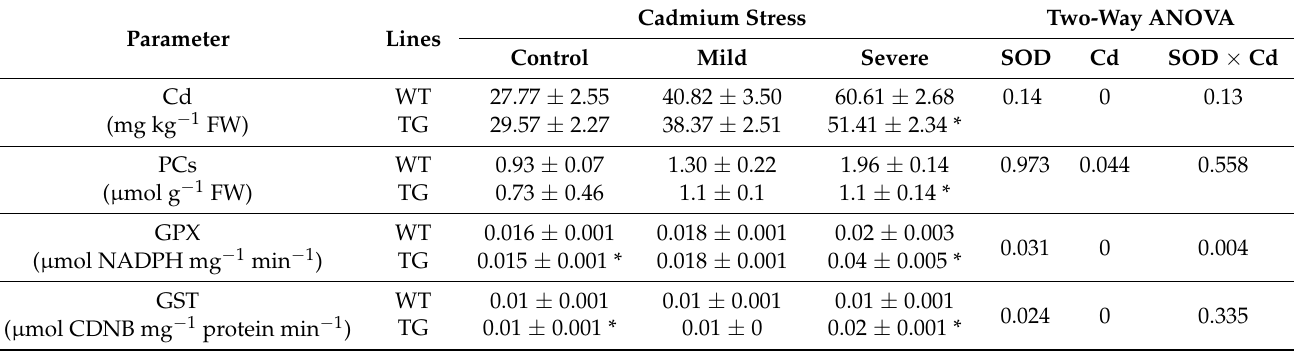
Table 3. Effect of Cd-stress on cadmium content (Cd) and its detoxification in the FeSOD overexpressing maize transgenic line (TG) and its wild type